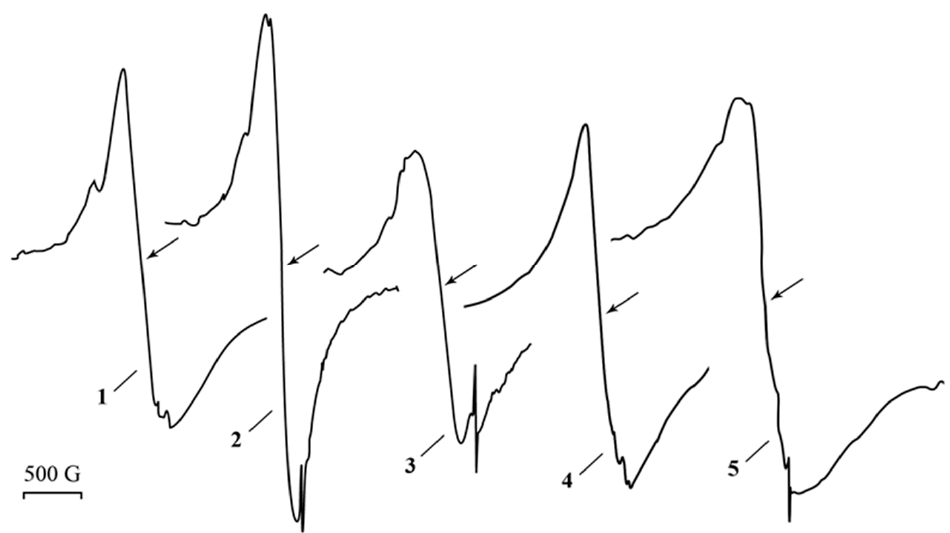
Figure 2. EPR spectra of PAAg: 1—freshly synthesized, 2—stored for one year; stimulated aging process of PAAg: 3—one hour after heating at 200 ◦ C, 4—one day after heating; 5—PAAg stored as aqueous solution for one year; the arrow indicates a g -factor equal to